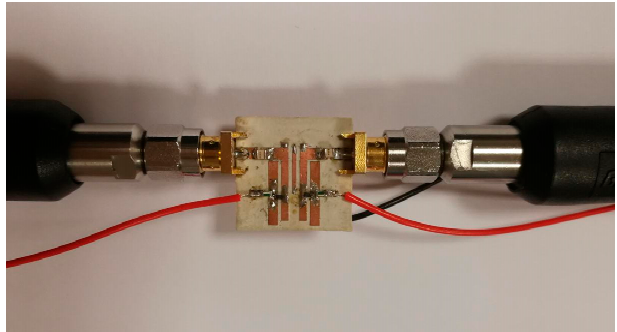
Figure 15. Hardware realization of the fabricated prototype for the proposed reconfigurable filter.